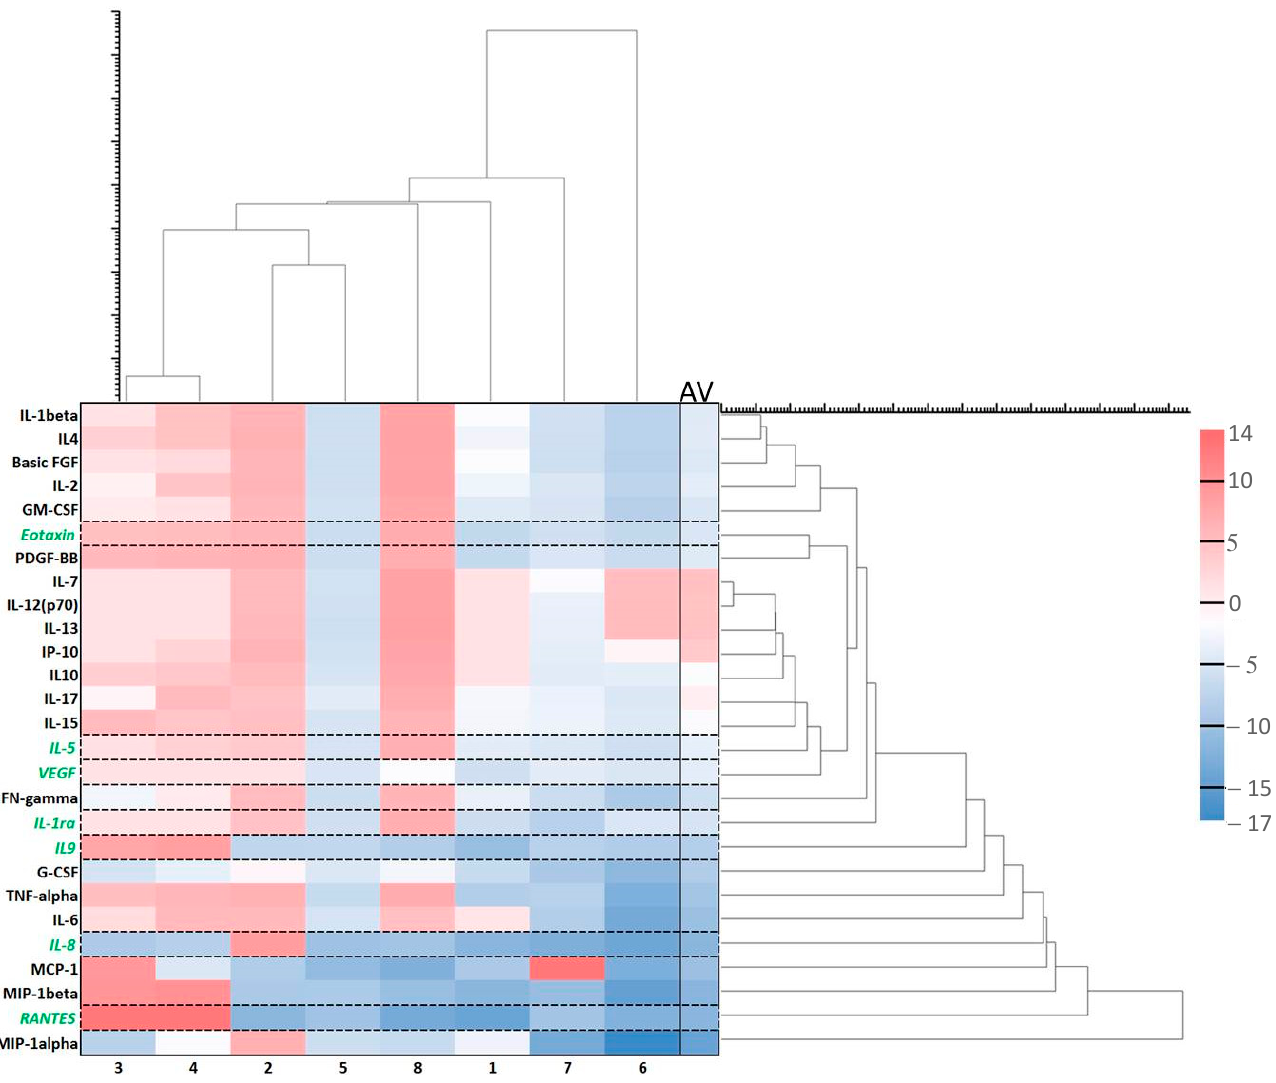
Figure 3. Effects of ALA alone on cytokines. Cytokine heatmap with log values. Log = sgn (ALA i − Ctrl i )*log 2 (|ALA i − Ctrl i |) where ALA i is the cytokine fluorescence intensity in the group with ALA alone and Ctrl i is the cytokine fluorescence intensity in the control group with no ALA or light. The pink colors represent increased cytokines while the blue ones show decreased cytokines after treatment with ALA alone. The heatmap is vertically clustered by log Euclidian distances and also horizontally clustered by various patient samples. The selected cytokines with the lowest variabilities are shown with the green color. AV is an average of the log values from different samples of eight patients.